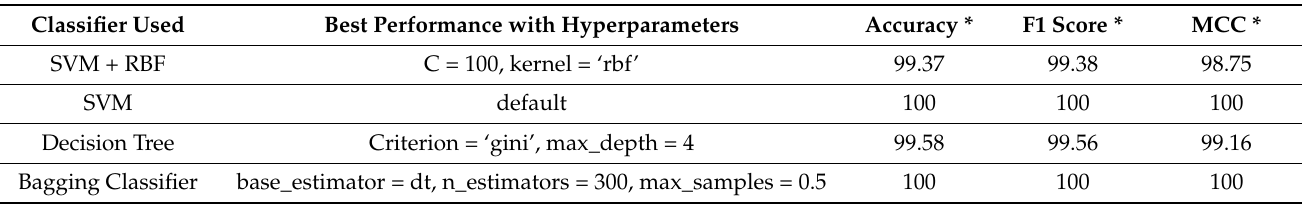
Table 7. Estimated performance over Dataset-2 under